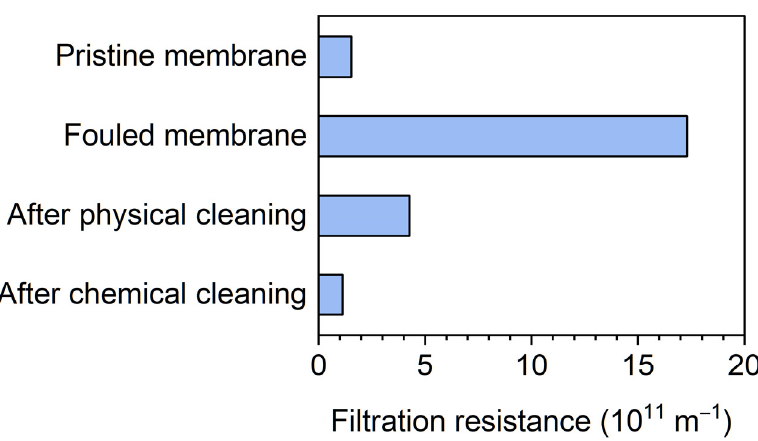
Figure 6. Filtration resistance values of the pristine membrane, fouled membrane, and cleaned mem- membrane. Physical and chemical cleaning were sequentially brane. Physical and chemical cleaning were sequentially performed.